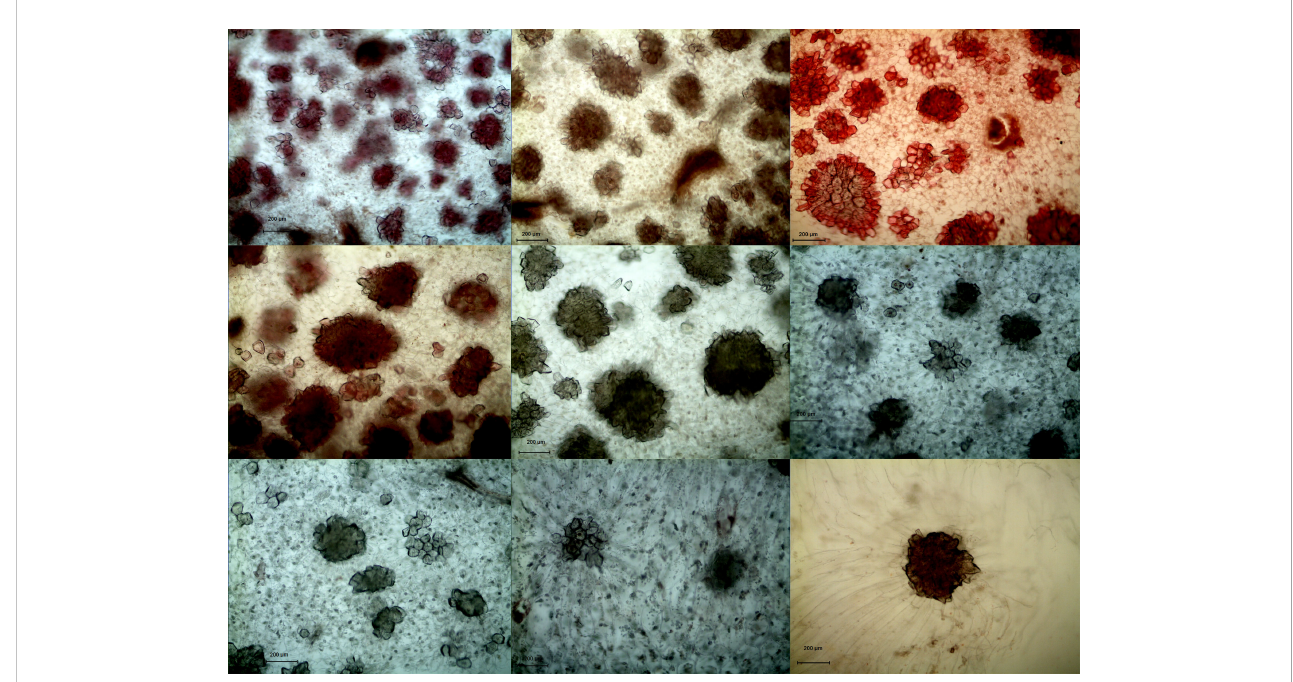
FIGURE 2 Microscopy of stone cell cluster development in DY(100×) A - I: 15d 、 23d 、 31d 、 39d 、 47d 、 55d 、 63d 、 87d 、 145d,